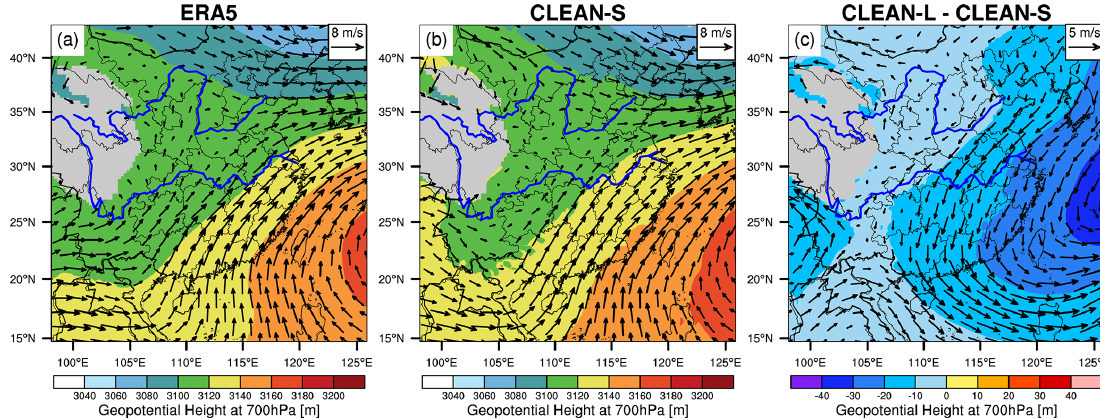
Figure 3. Spatial distributions of mean geopotential height and wind fields at 700hPa of June and July 2017 from (a) ERA5, (b) CLEAN-S, and (c) difference between CLEAN-L and